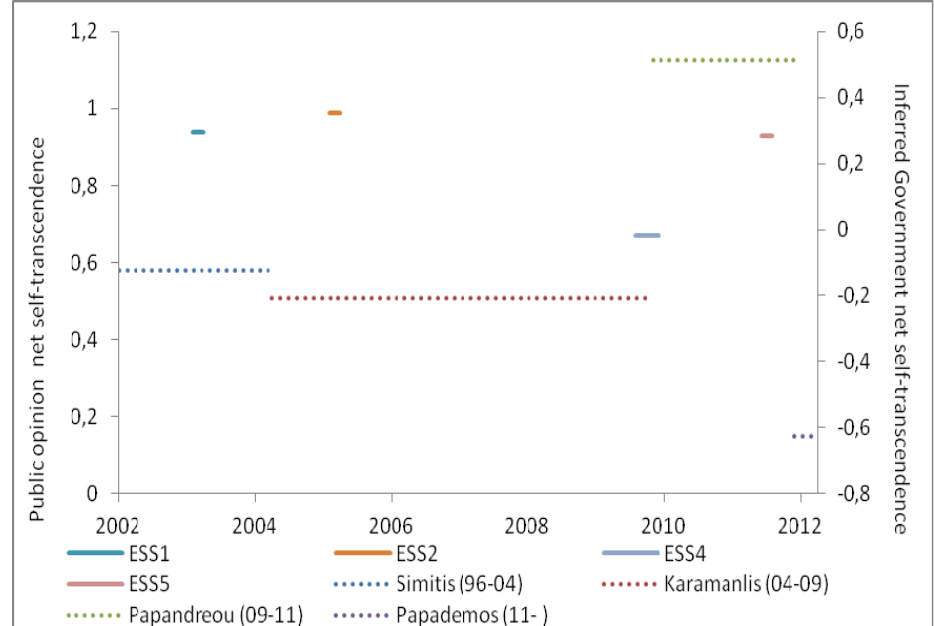
Figure 7: Net self-transcendence for